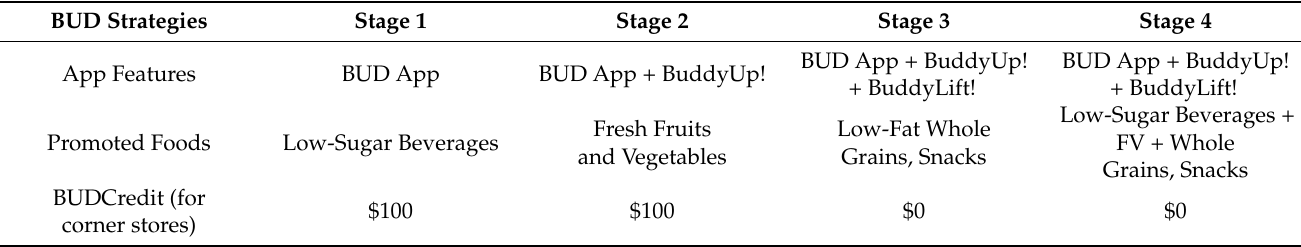
Figure 3. BUD corner store owner screen mockups. Table 1. Stages of implementation of the BUD app during the